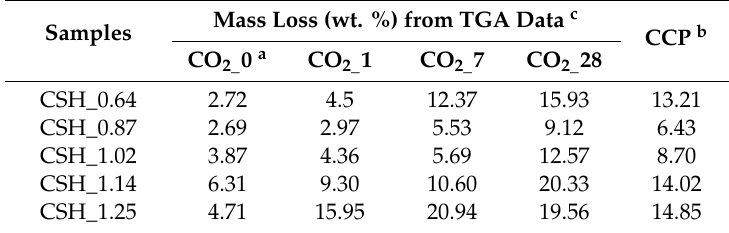
Figure 4. TGA patterns of C-S-H ( a ) before carbonation and ( b ) after carbonation for 28 days.